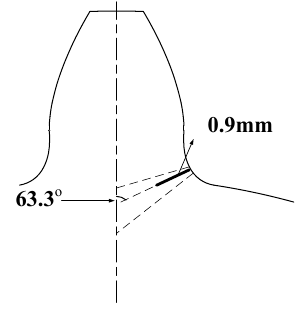
Figure 6. Gear tooth microcrack model.